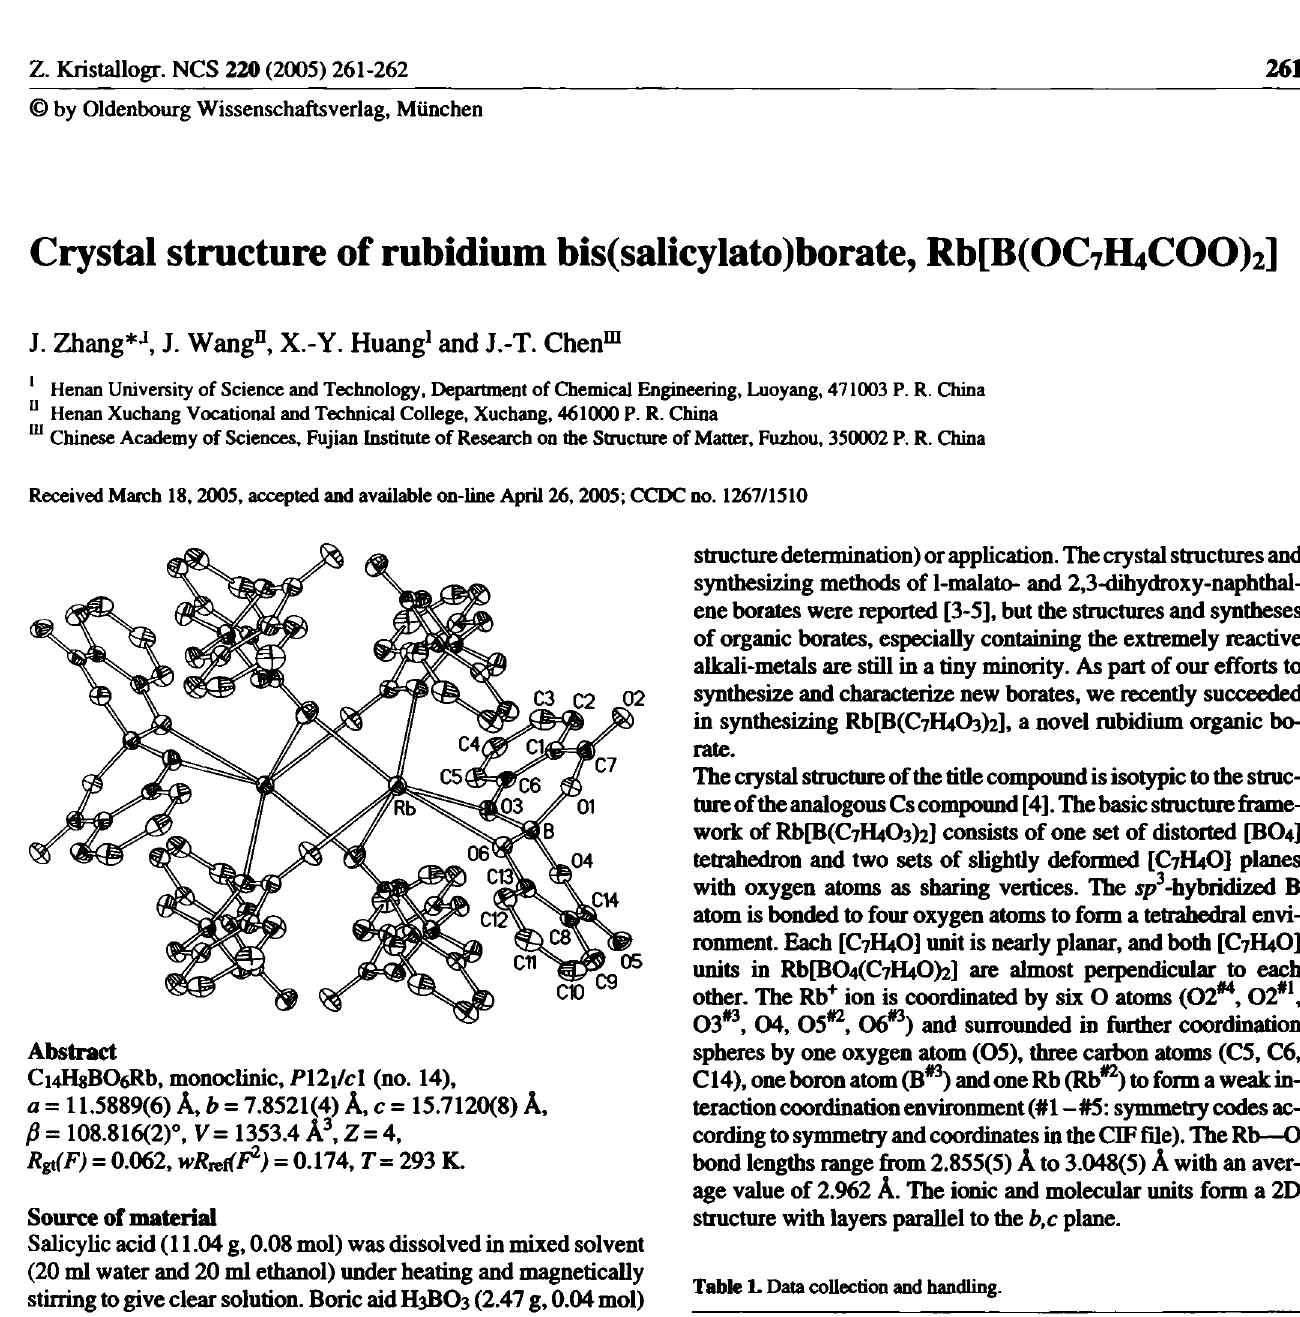
Table 2. Atomic coordinates and displacement parameters (in A 2